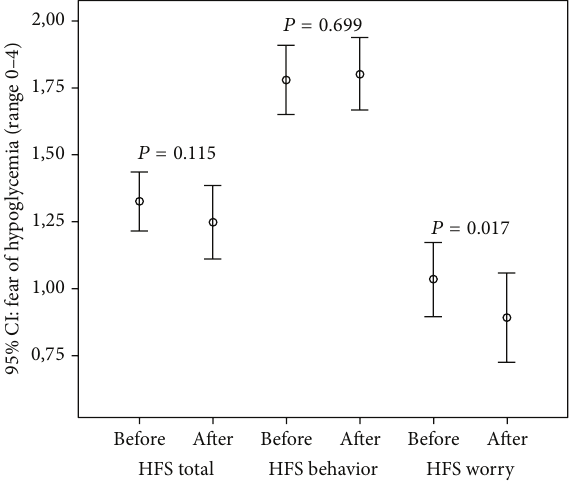
Figure 1: Hypoglycaemia Fear Survey (HFS) before and after 4 nights with the MD-Logic artificial pancreas in home setting ( 𝑛 = 58